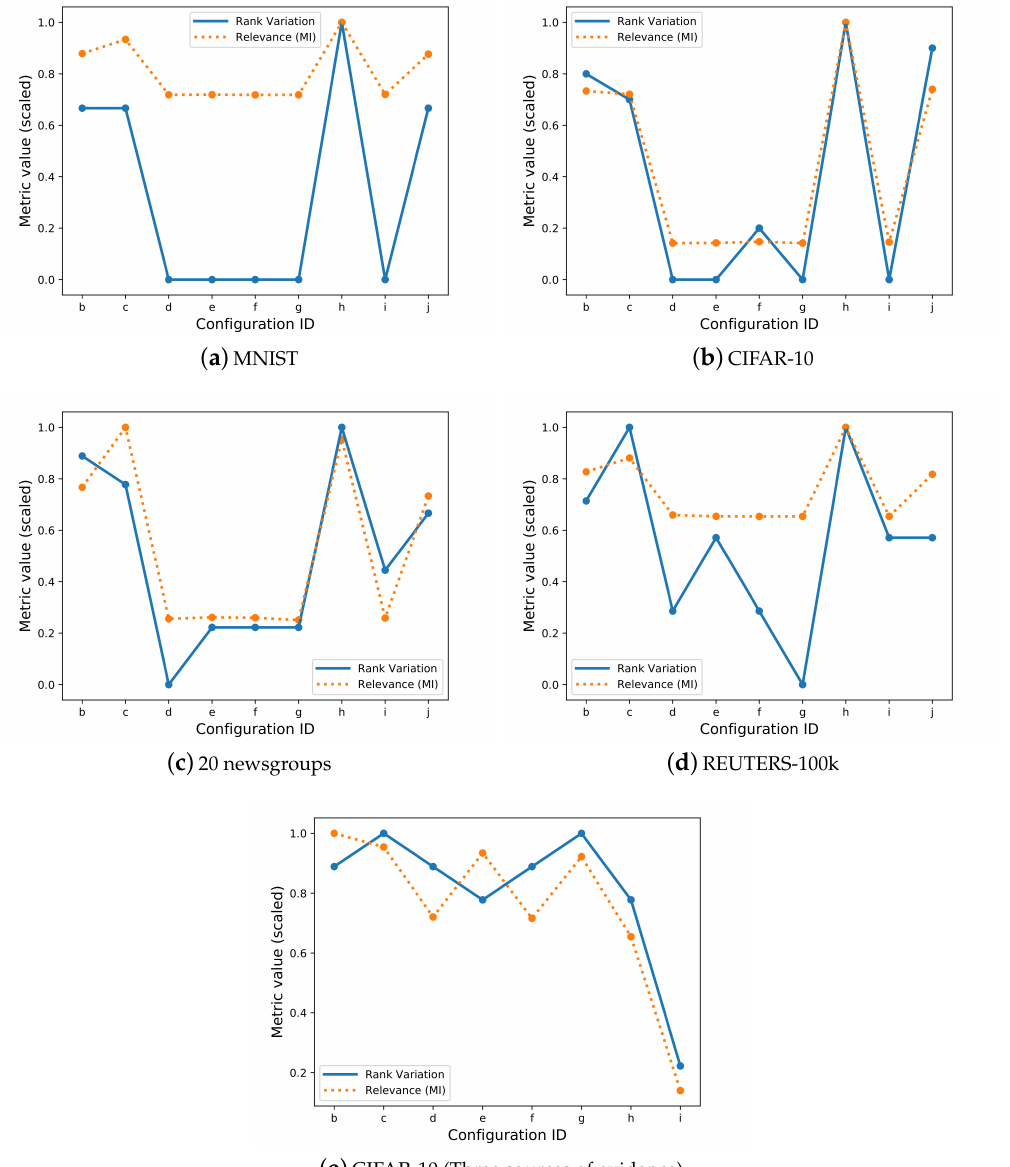
Figure 2. A comparison between the Rank Variation and Relevance metric (Mutual Information estimation): For visualisation purposes, we normalise all four metrics using the max norm. Individual latent feature significances in cases of of real corresponding evidence seem to be correlated with the overall relevance measurements. In some cases of low quality evidence, inconsistencies in the behaviour of the ranking variation on the individual latent feature level are observed, which mostly represent swapping rankings between two or four features due to incremental reconstruction